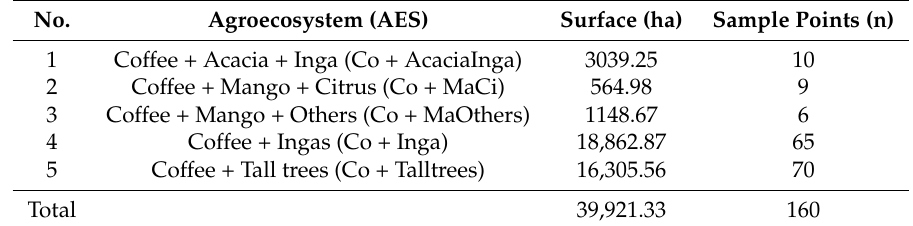
Table 1. Surface and number of sampling points by type of coffee agroecosystem in the central region of Veracruz, México